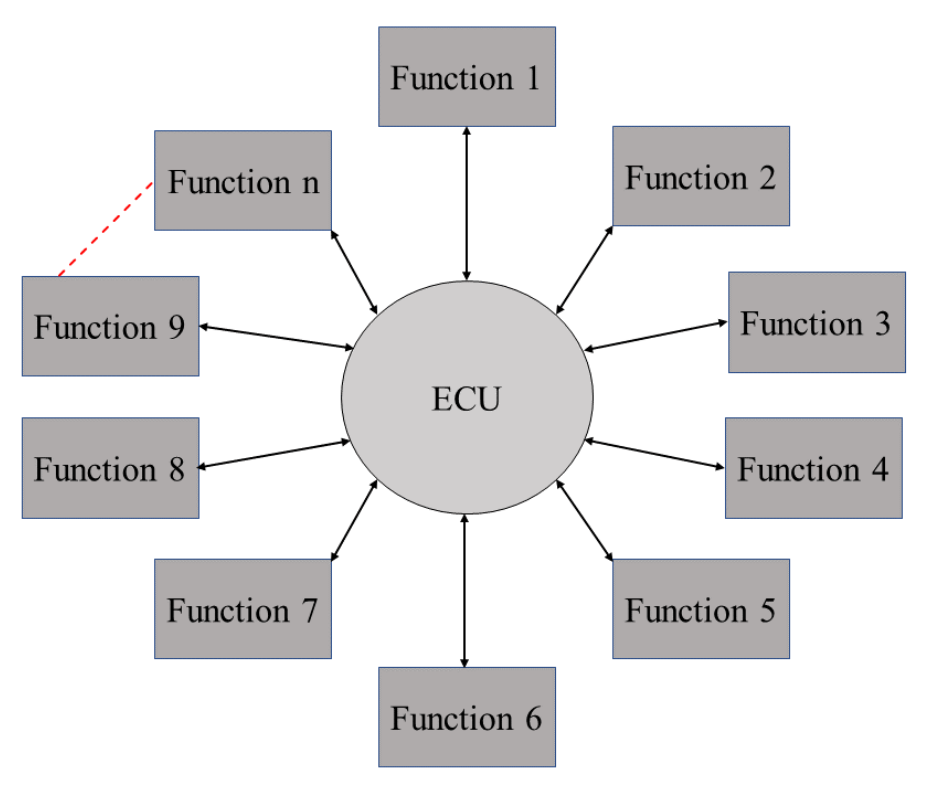
Figure 22. Representation of High-Power ECU